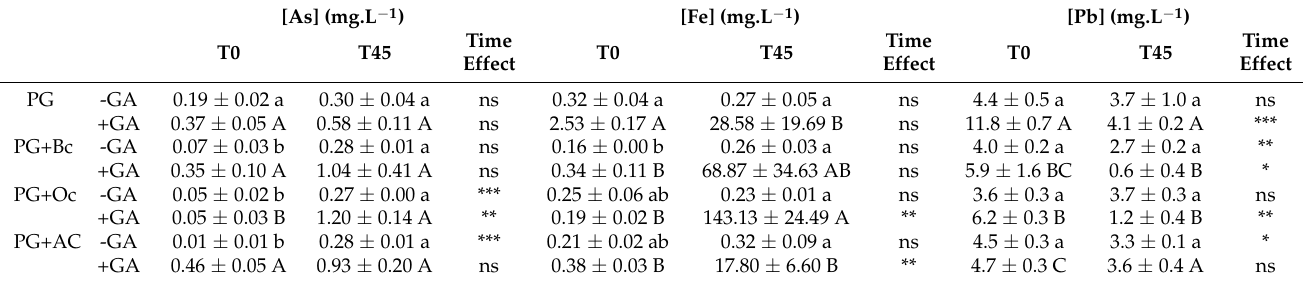
Table 2. Soil pore water metal(loid) (As, Fe, Pb) concentrations (mg.L − 1 ) determined at the beginning (T0) and at the end of the experiment (T45) in Pontgibaud technosol alone (PG) or amended with biochar (PG+Bc), ochre (PG+Oc) and activated carbon (PG+AC), associated or not with green amendment (+/ − GA). Small letters indicate a significant difference between the treatments without green amendment while capital letters indicate a significant difference in between the conditions with the green amendment ( p < 0.05) (n = 5 ±